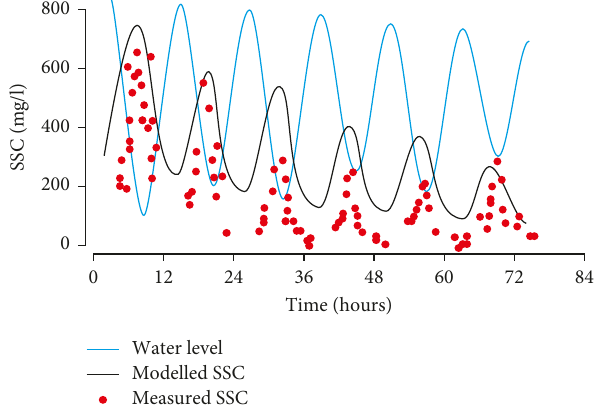
Figure 8: Details of measured water level and SSC (intermittent samples) and predicted SSC from a calibrated cohesive sediment